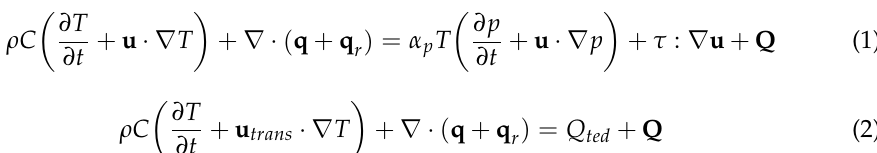
Table 1. Material properties used in the Computational Fluid Dynamics (CFD) model.